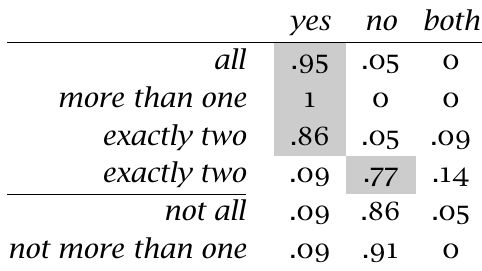
Table 4 : Response rates for the critical and DE control items in Experiment 4 . The percentages in the shaded cells are inconsistent with minimal conventionalism. As in Experiment 3 , there were two trials with exactly two .